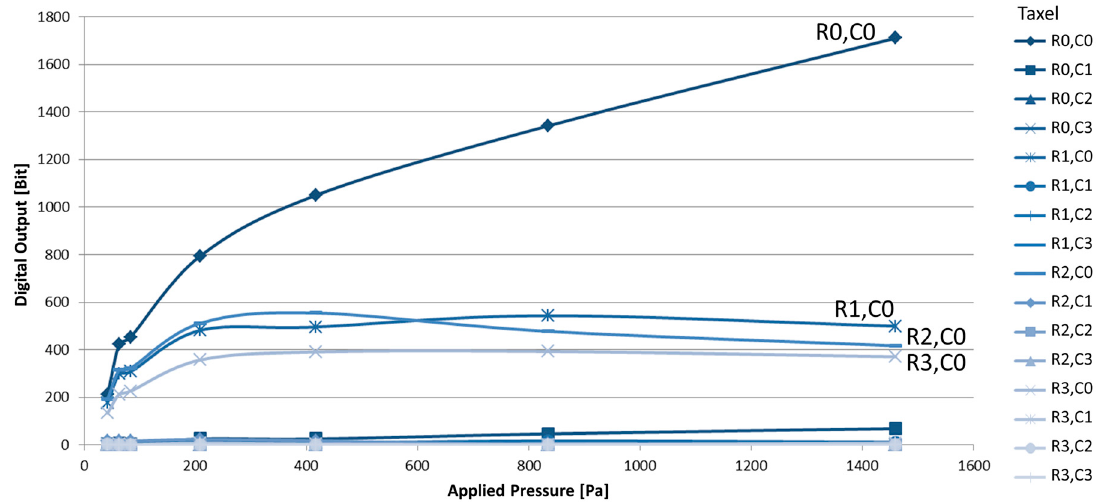
Figure 13. Example of textile pressure sensing matrix response after the application of different pressures in position (R0,C0).